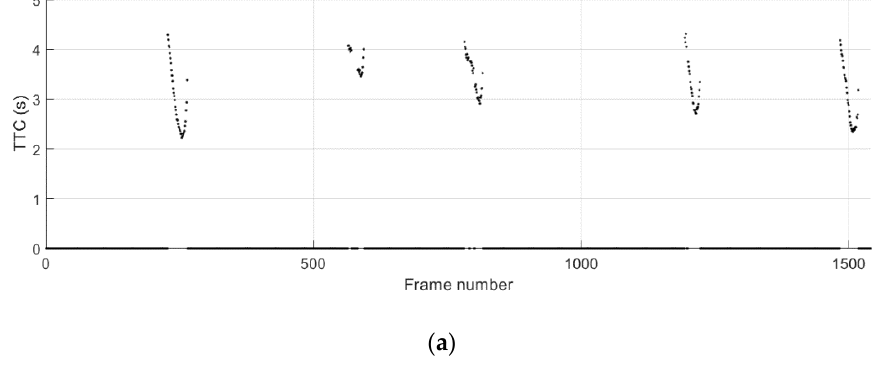
Figure 15. Relative distance to the remote vehicle during the cut-in driving scenario 2. ( a ) Ground truth longitudinal distance; ( b ) ground truth lateral distance; ( c ) absolute error for longitudinal distance estimates; ( d ) absolute error for lateral distance estimates.